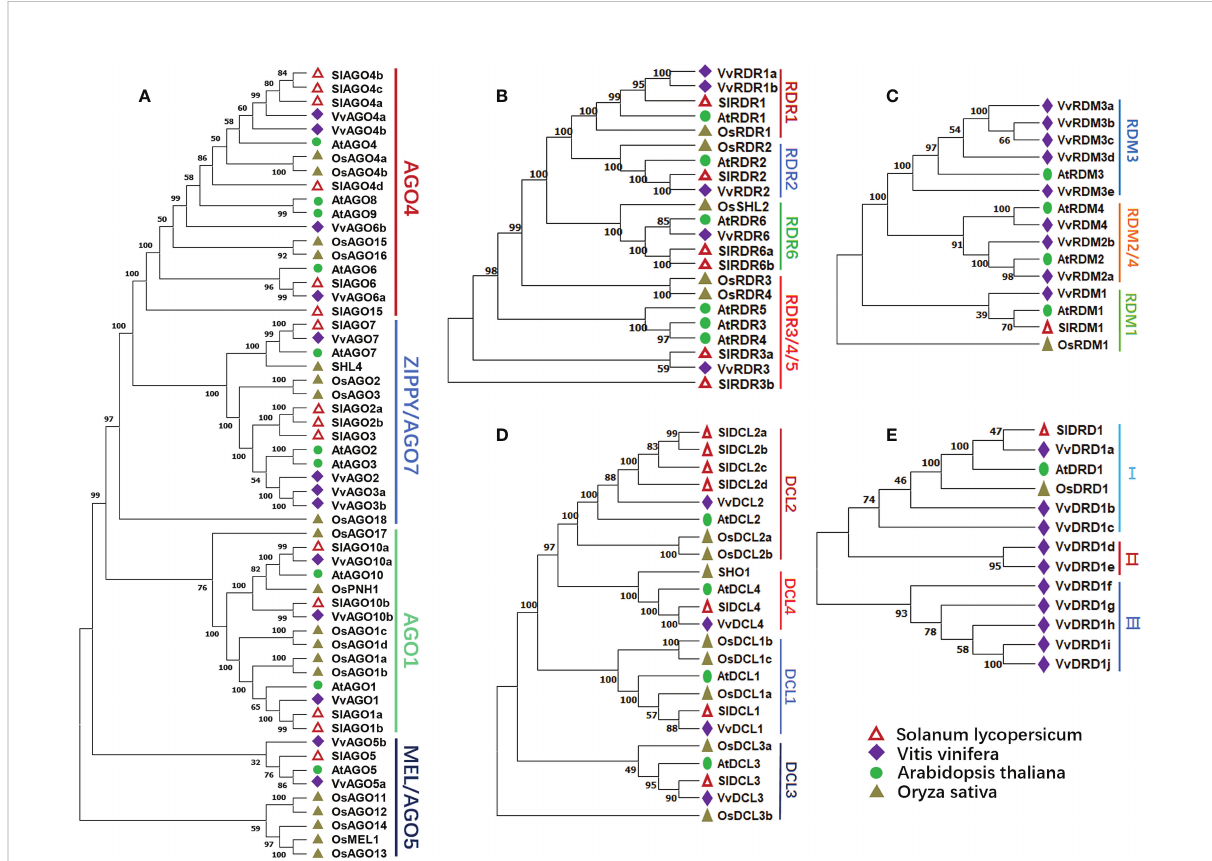
FIGURE 1 Phylogenetic analysis of AGO, RDR, RDM, DCL, and DRD proteins from grape, Arabidopsis, tomato, and rice. Hollow triangle, diamonds, circles, and triangle represent tomato, grapes, Arabidopsis, rice proteins, respectively. Numbers near the branches denote bootstrap values. (A) Phylogenetic tree of AGO proteins. AGO4, AGO7, AGO1, and AGO5 represent different subgroups. (B) Phylogenetic tree of RDR proteins. RDR1, 2, 3, 4, and 5 represent different subgroups. (C) Phylogenetic tree of RDM proteins. RDM1, 2, 3, and 4 represent different subgroups. (D) Phylogenetic tree of DCL proteins. DCL1, 2, 3, and 4 represent different subgroups. (E) Phylogenetic tree of DRD proteins. I, II, and III represent different